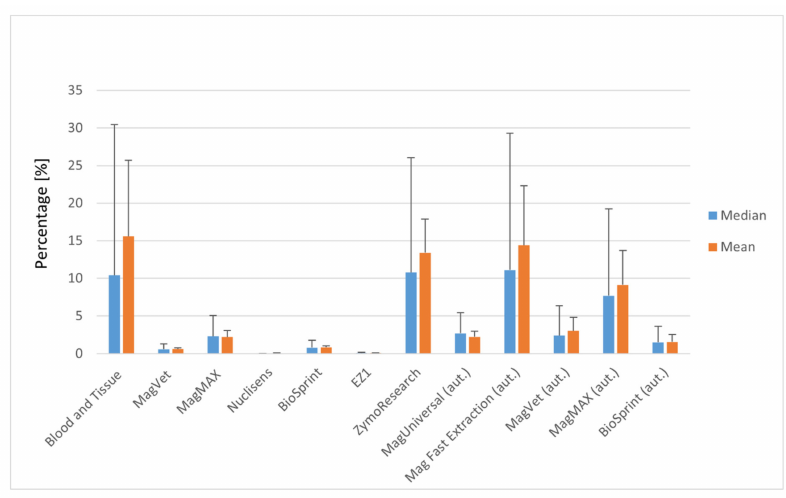
Figure 1. E ffi ciency of Mycobacterium avium subsp. paratuberculosis (MAP) DNA isolation in milk using selected isolation kits: DNeasy ® Blood and Tissue kit (QIAGEN, Hilden, Germany), MagVet Mycobacterium paratuberculosis Isolation Kit (LSI, Lissieu, France), MagMAX ™ Total Nucleic Acid Isolation Kit (Applied Biosystems by Thermo Fisher Scientific, Vilnius, Lithuania), Nuclisens Magnetic Extraction Reagents (Biom é rieux, Marcy-l’ É toile, France), BioSprint 96 One-For-All-Vet (QIAGEN, Hilden, Germany), EZ1 DNA Tissue Kit (QIAGEN, Hilden, Germany), ZR Quick-DNA Fecal Soil Microbe Microprep Kit (Zymo Research, Tustin, CA, USA), ID Gene